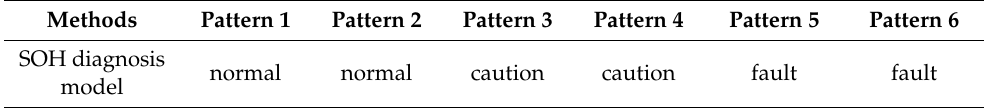
Table 3. The SOH diagnosis result for the proposed